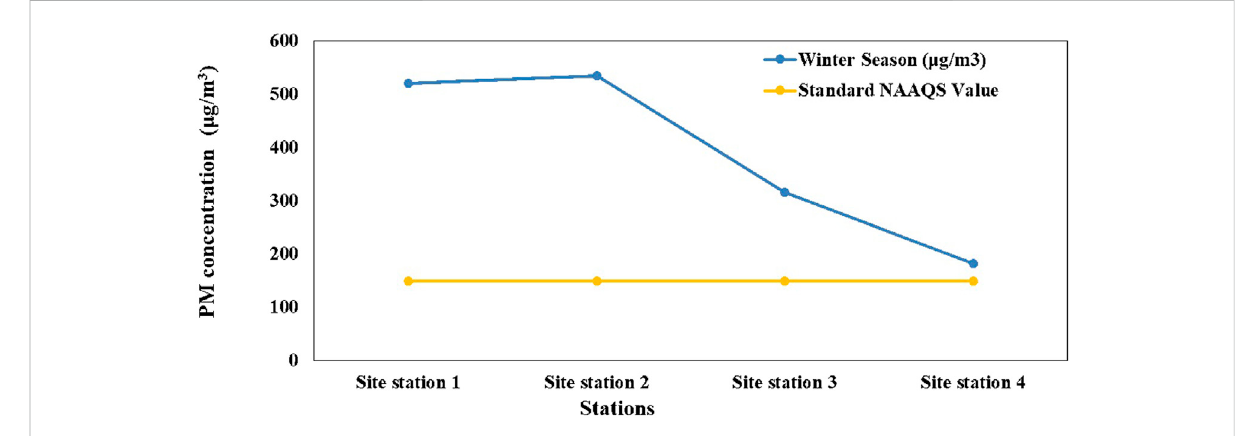
FIGURE 3 PM concentration in the winter season.